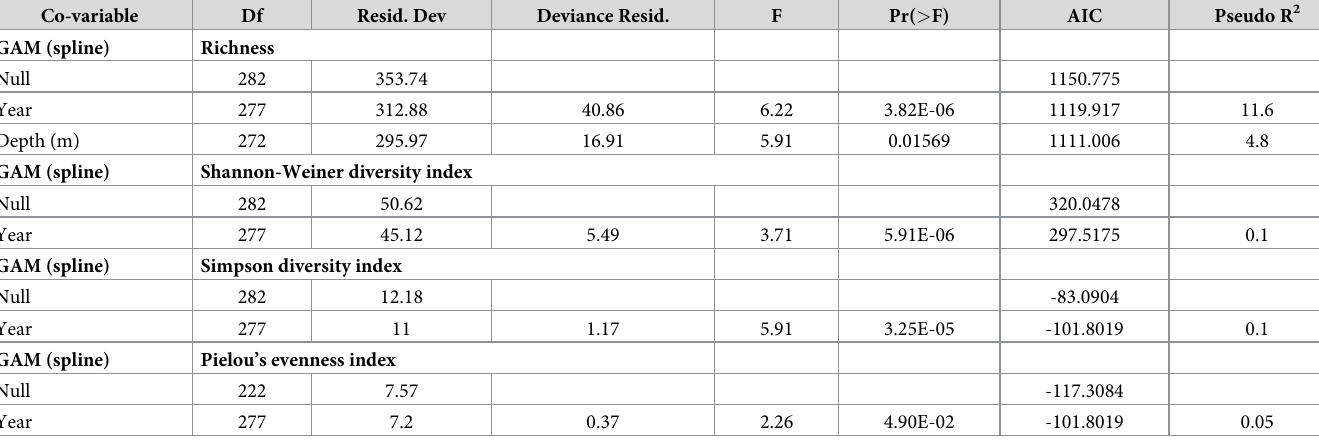
Table 5. Main results of the GAM modelling for alpha-diversity indices of discarded faunal demersal